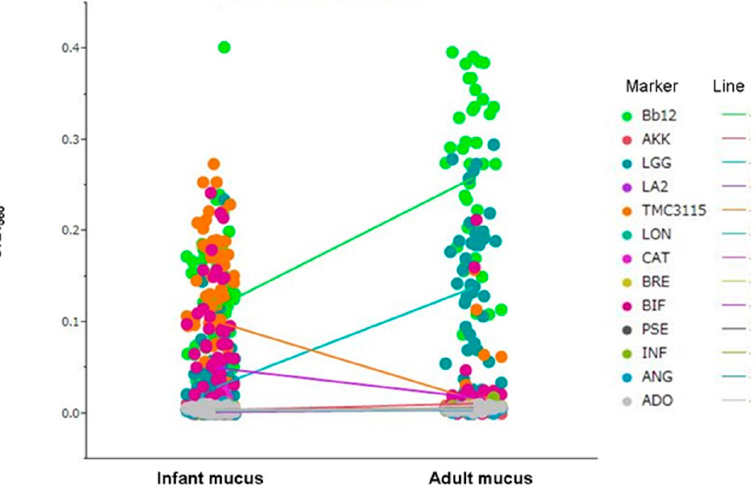
Figure 2. Adherence properties of bacterial strains to human mucus originating from infant and adult stools. Infant mucus was isolated from stools obtained from infants aged within 5 days old, 1 month old, 4 months old, 6 months old, 9 months old, 1 year old, 1 and a half years old, and 3 years old. Adult mucus was isolated from those aged 20–29, 30–39, 40–48, and 50–59 years